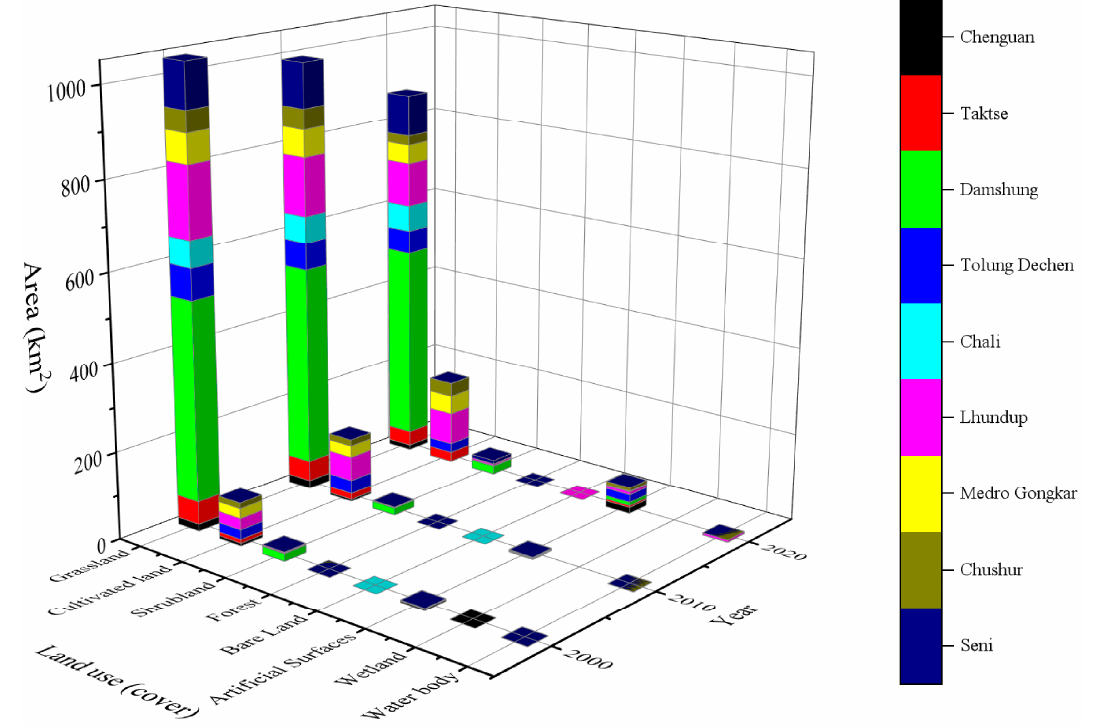
Figure 4. Land use/cover area of different counties/districts in different years (km 2 ).